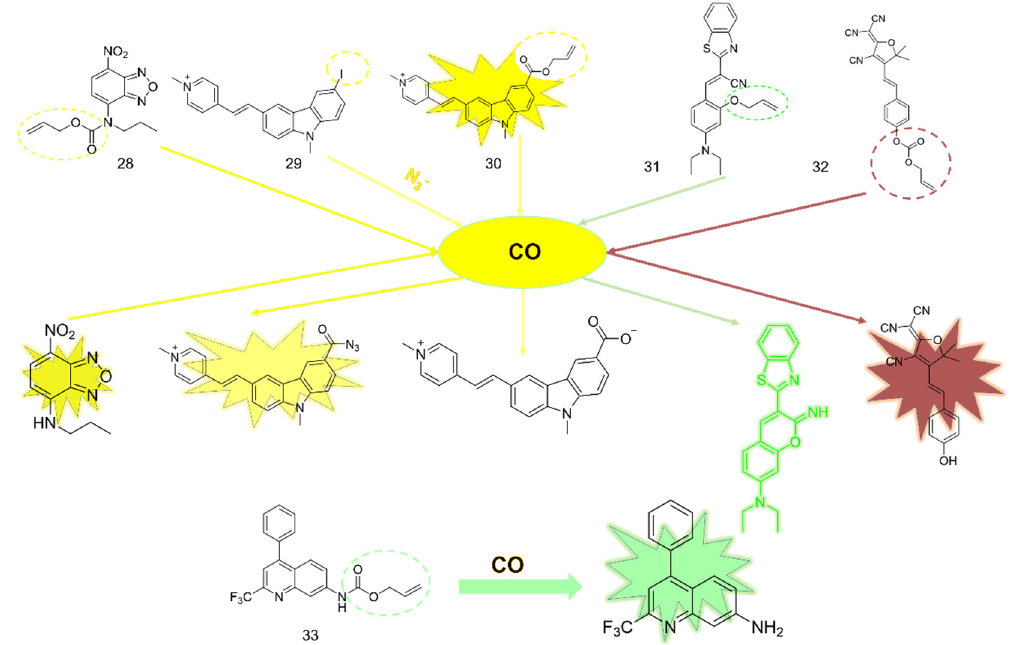
Figure 12. The chemical structures of other CO fluorescent probes.